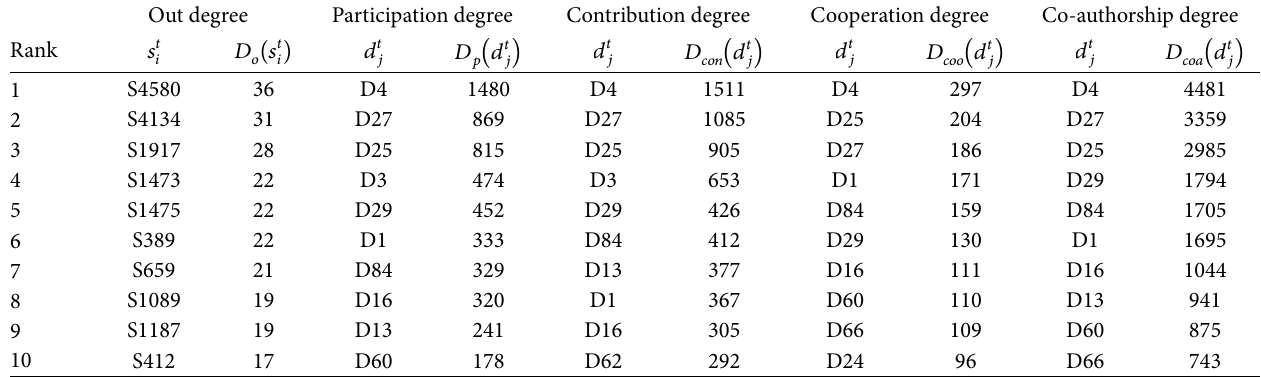
Table 4: The top ten standards and drafters in high indicators till